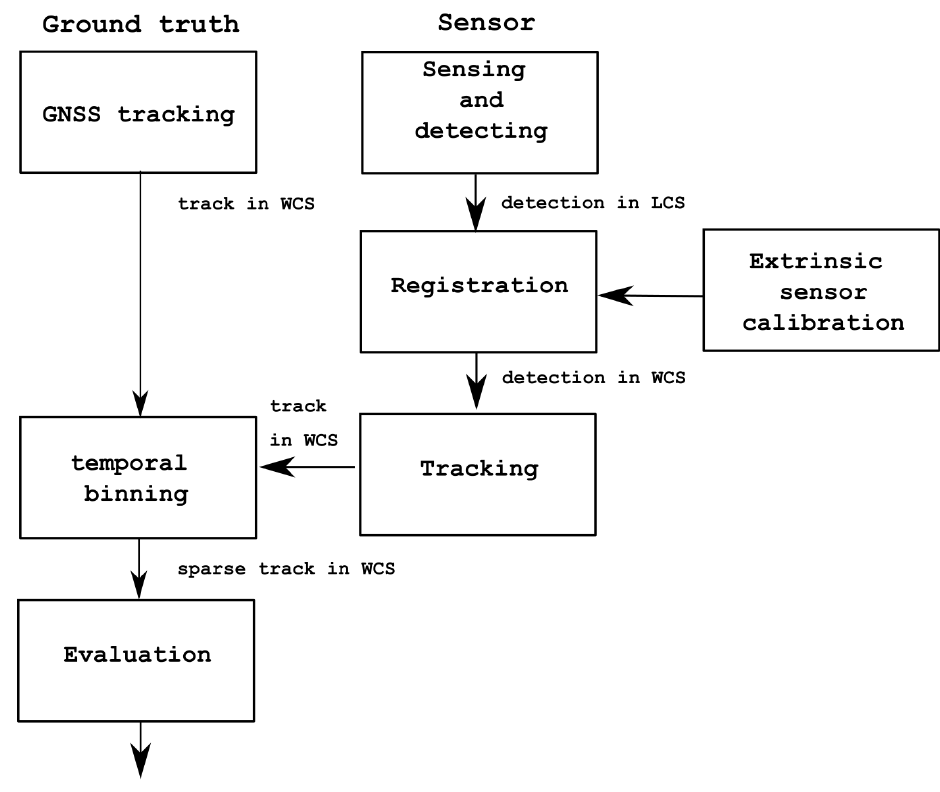
Figure 5. Schematic of data processing for single sensors (e.g., PIR and thermal camera) from detection to transformation between local coordinate system (LCS) to world coordinate system (WCS) and